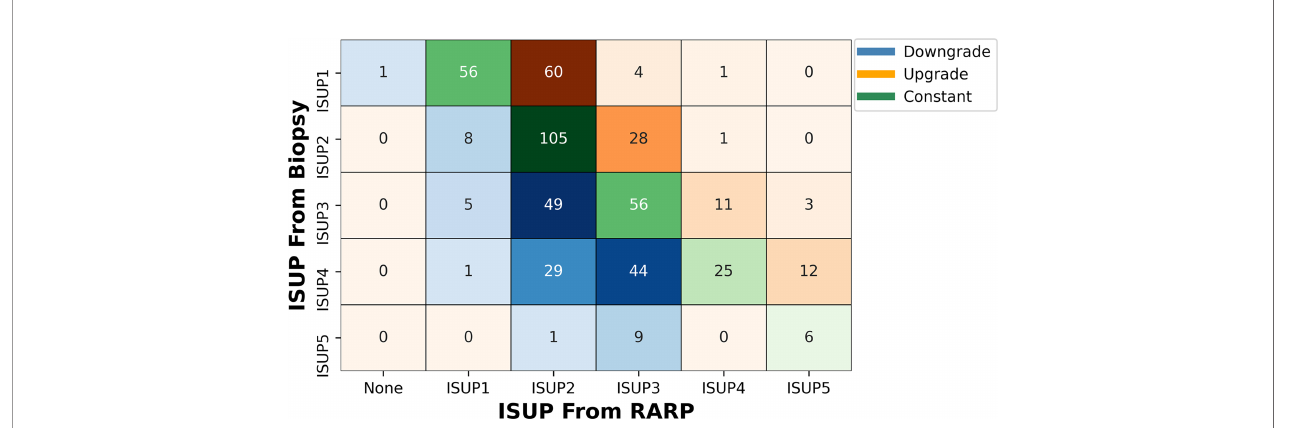
FIGURE 2 | Volume plot of pathological results from combined biopsy to fi nal RARP according to ISUP grade group. The shade of color re fl ects the number. ISUP, International Society of Urological Pathology; RARP, robot-assisted laparoscopic radical prostatectomy.